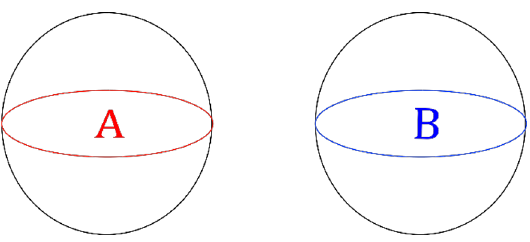
Figure 1 . We consider the entanglement between two disjoint universes, A and B . Both universes have propagating matter, but only B gravitates. The universes may be closed and bounded as illustrated, or